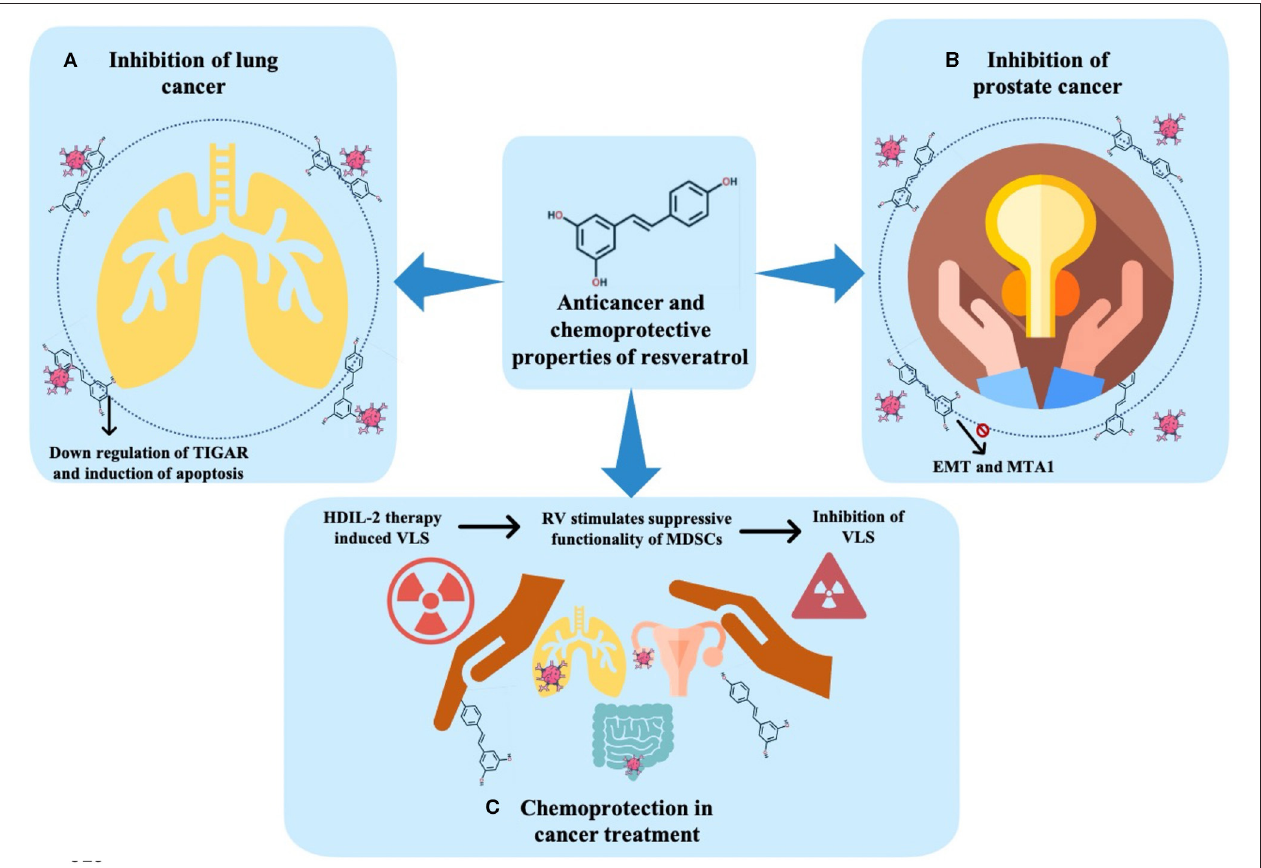
FIGURE 3 | Anticancer and chemoprotective effects of resveratrol. (A) Inhibition of lung cancer. (B) Inhibition of prostate cancer. (C) Chemoprotection in cancer treatment. TIGAR, tumor protein (TP) 53-induced glycolysis and apoptosis regulator; EMT, epithelial-mesenchymal transition; MTA, metastasis-associated protein; HDIL-2, high-dose interleukin-2; RV, resveratrol; MDSCs, myeloid-derived suppressor cells; VLS, vascular leak